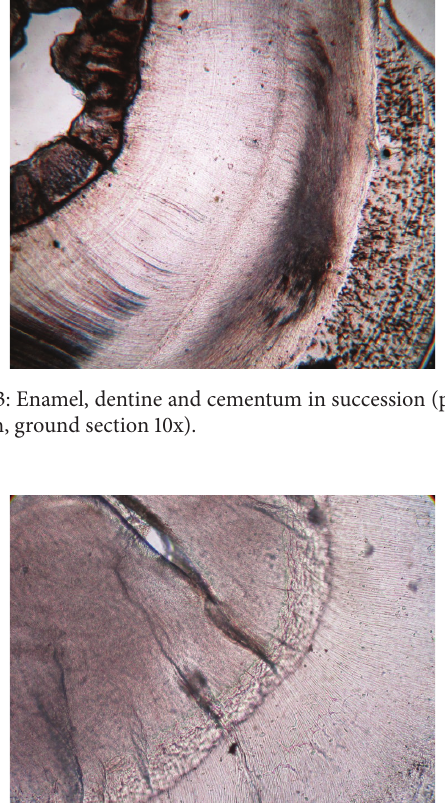
Figure 2: Superior and inferior surface of odontoma.